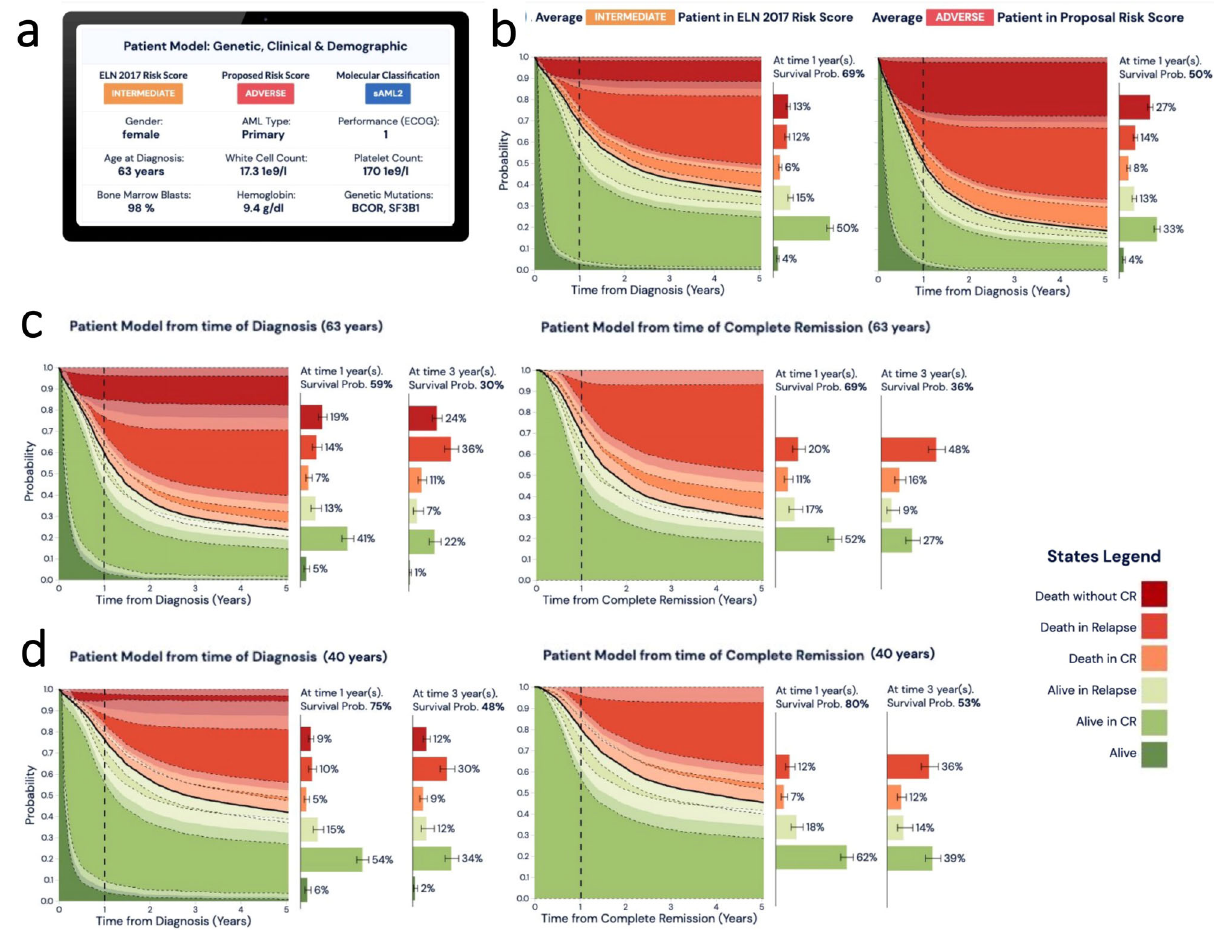
Fig.6 |Examplepresentationofpersonalizedclinicaldecisionsupporttoolfor molecular classi fi cation and risk strati fi cation. The calculator is derived using the multi-state models that consider data from ( n =3201 total patients, UK-NCRI and AMLSG) all intensively treated. a Input parameters to include cytogenetic, genetic, clinical and demographic are considered to ( b ) display each patient ’ s ELN 2017 score alongside with the proposed risk group developed in this study. To further improve interpretation con fi dence, we provided con fi dence intervals for each sediment plot and probability estimate transitions. The lower and upper whiskers represent the 95% CIs. Stacked sediment plots for each patient represent the likelihoodto transition between clinicalendpointsacross time. X -axis indicates time from diagnosis in years. Y -axis indicates probability for each transition. Black line indicates probability of survival across time. Vertical dotted line indicates the 1yeartimeframe.Horizontalbarplotsindicatetheprobabilityofattainingeachone